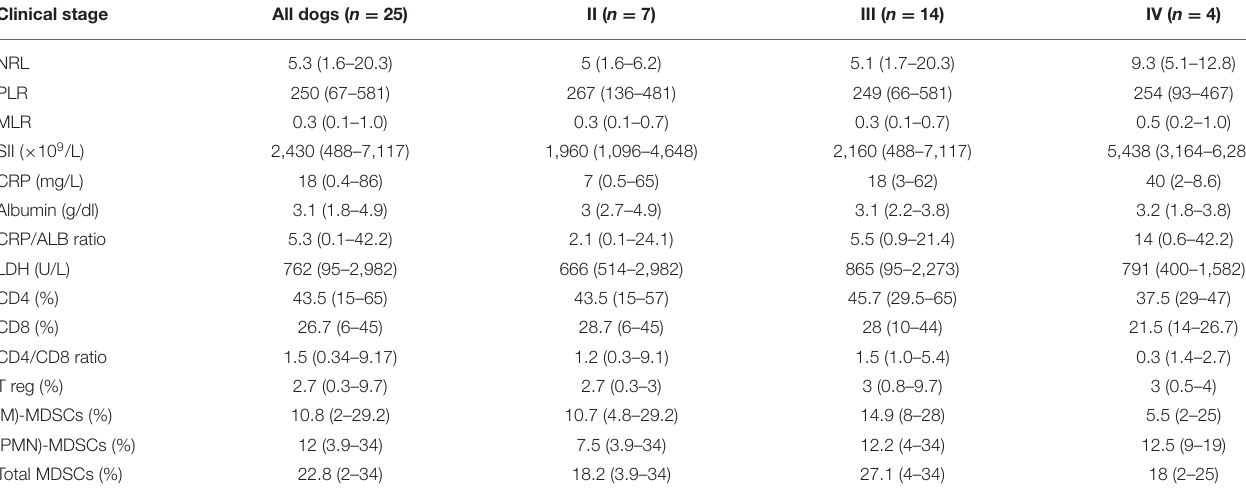
TABLE 2 | Median, minimum, and maximum value of inflammatory indices (NRL, PLR, MLR, SII, and CRP/ALB ratio), CRP, albumin, LDH, and frequency of circulating cells (lymphocytes CD4 + , CD8 + , CD4/CD8 ratio, Tregs, (M)-MDSCs, and (PMN)-MDSCs) according to clinical stage. Clinical